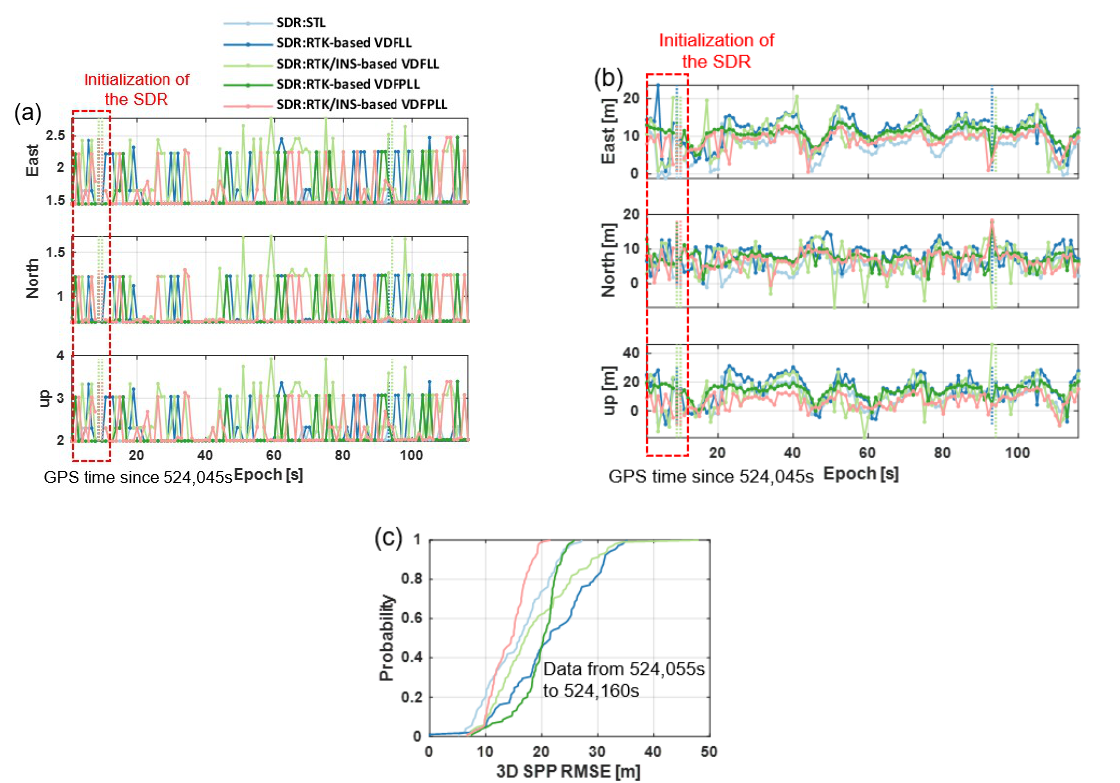
Figure 12. Single point navigation results and statistical analysis of different SDRs in the semi-open- sky situation where dashed lines correspond to the outlier epochs. ( a ) DOP values ( b ) SPP results ( c ) CDF curves of 3D SPP